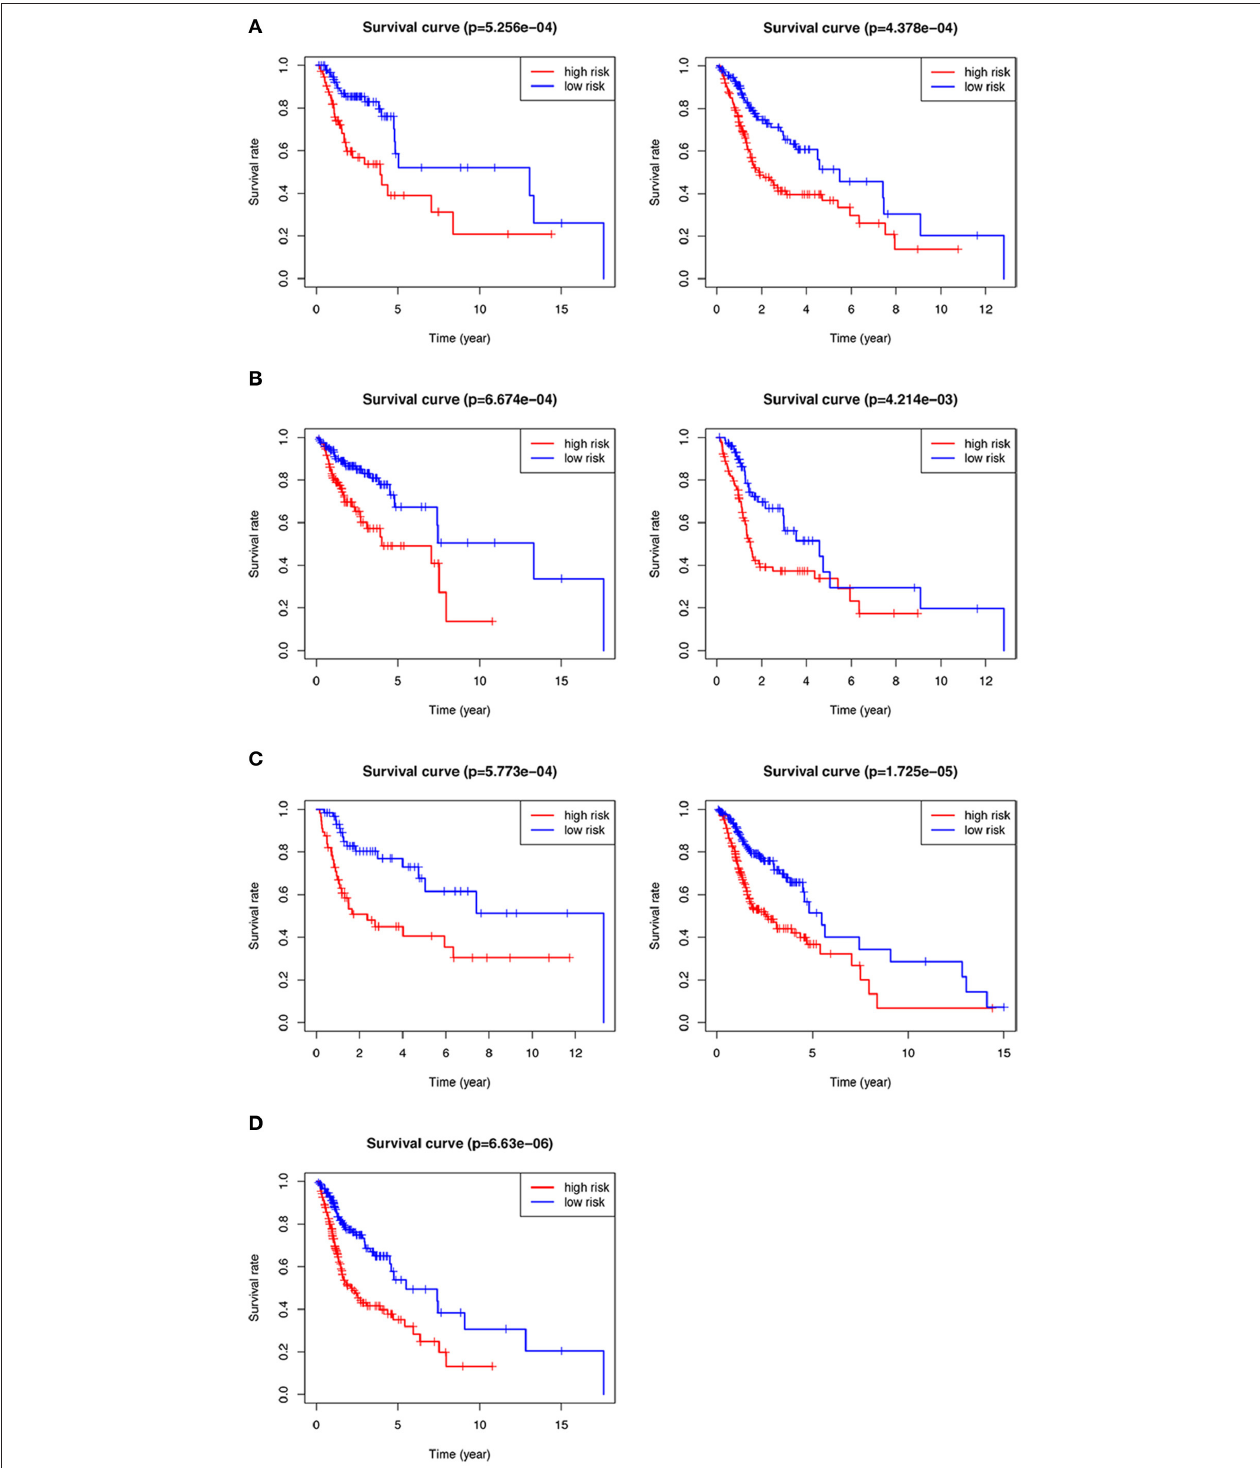
FIGURE 5 | Kaplan–Meier analysis of different subgroups in the TCGA test set. (A) T1-2 & T3-4 patients. (B) N0-1 & N2-3 patients. (C) G1-2 & G3-4 patients. (D) Stage III-IV patients.